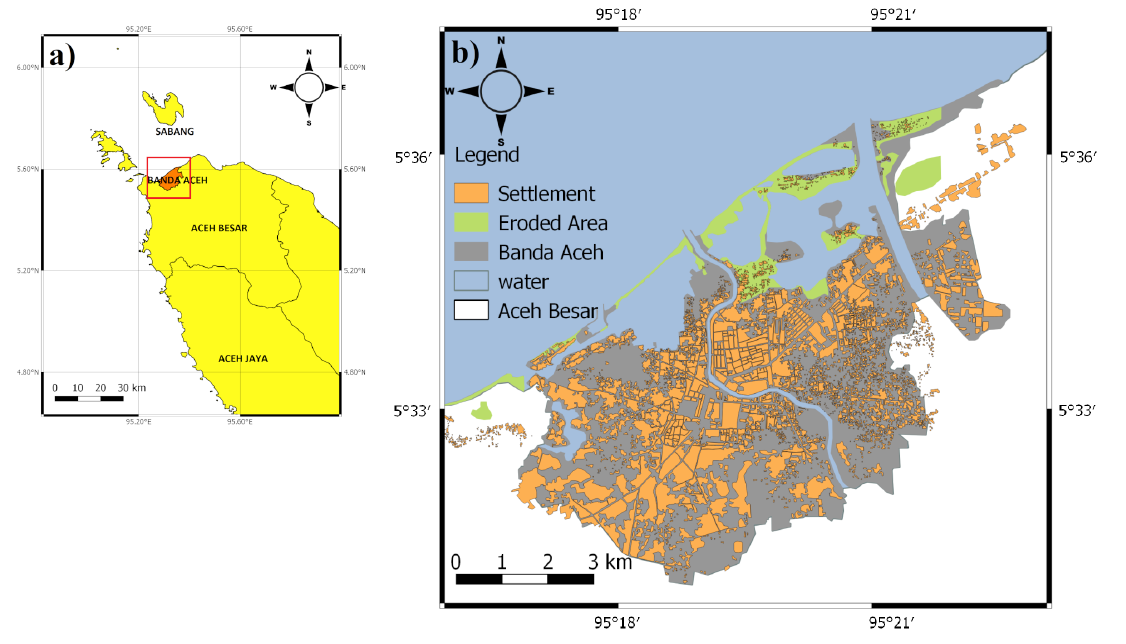
Figure 1. ( a ) Study area and ( b ) Banda Aceh city before and after the 2004 Indian Ocean Tsunami (green color indicates the land area eroded by the tsunami). This figure was modified from